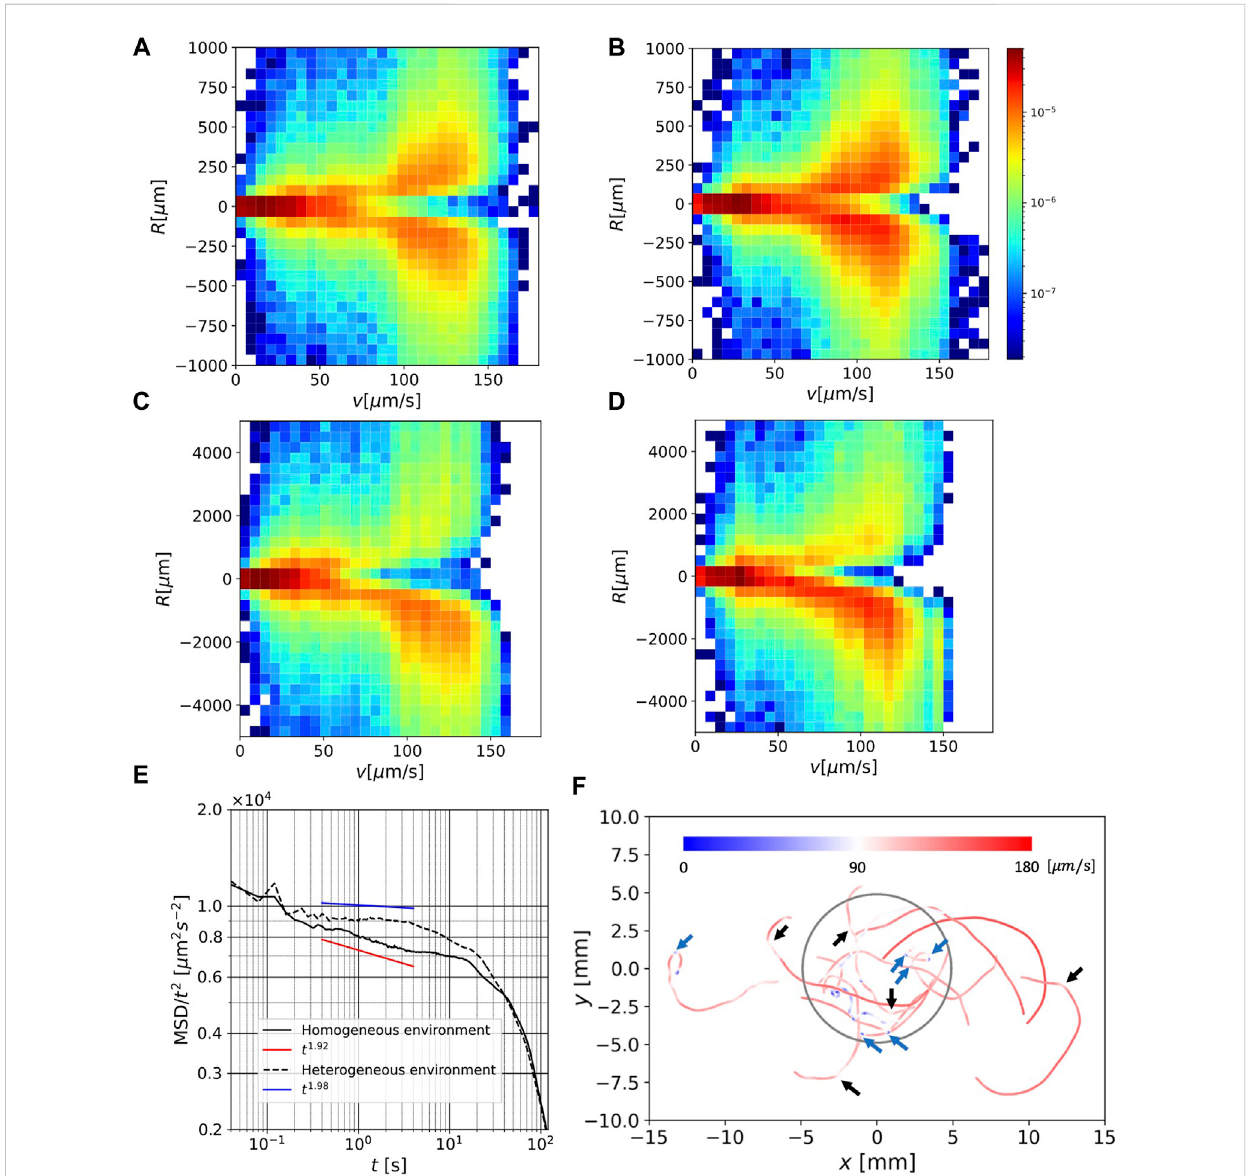
FIGURE 4 (A) Joint distribution of speed v and curvature radius R for 1 s-average orbit in a homogeneous environment. (B) As in (A) but in a heterogeneous environment. (C) As in (A) , but for 10 s-average orbit. (D) As in (C) but in a heterogeneous environment. (E) MSDs for all orbits under homogeneous and heterogeneous conditions. (F) Selected 5 s-average orbits in a heterogeneous environment, colored by local speed. The blue parts indicate speeds less than 90 μ m/s and the red parts indicate speeds larger than 90 μ